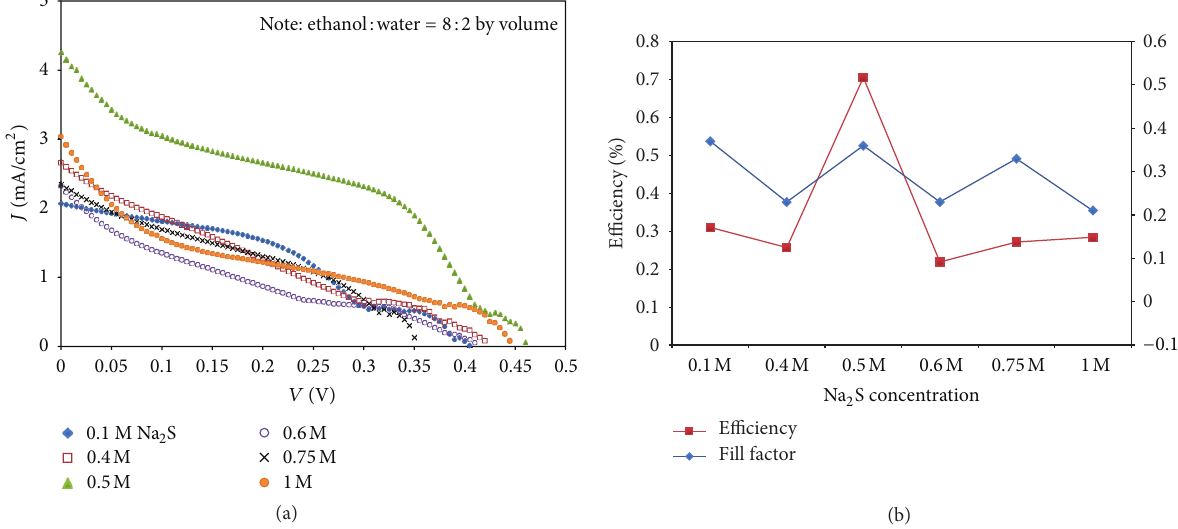
Figure 2: (a) 𝐽 - 𝑉 curves of CdSe QDSSCs with electrolytes having various amounts of Na 2 S. (b) Variation of efficiency and fill factor of the cells with the amount of Na 2 S in the